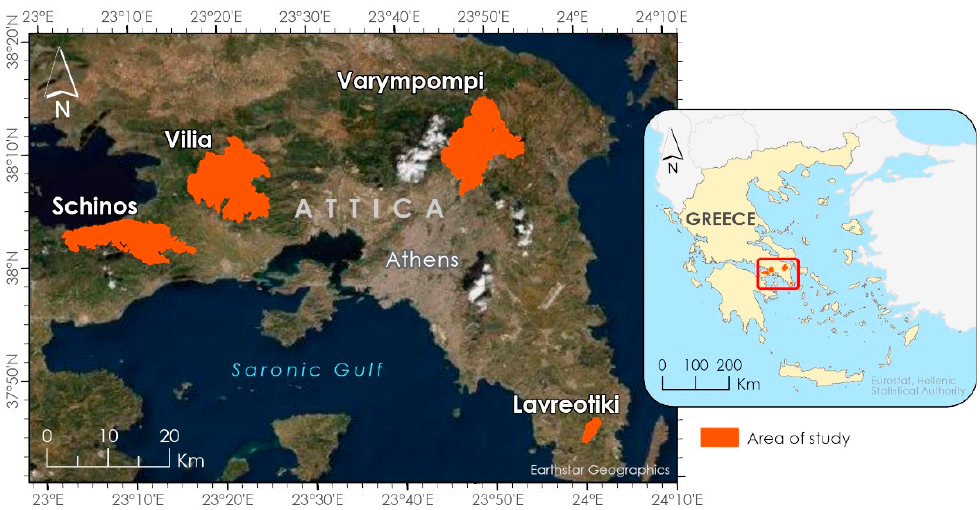
Figure 1. Areas of